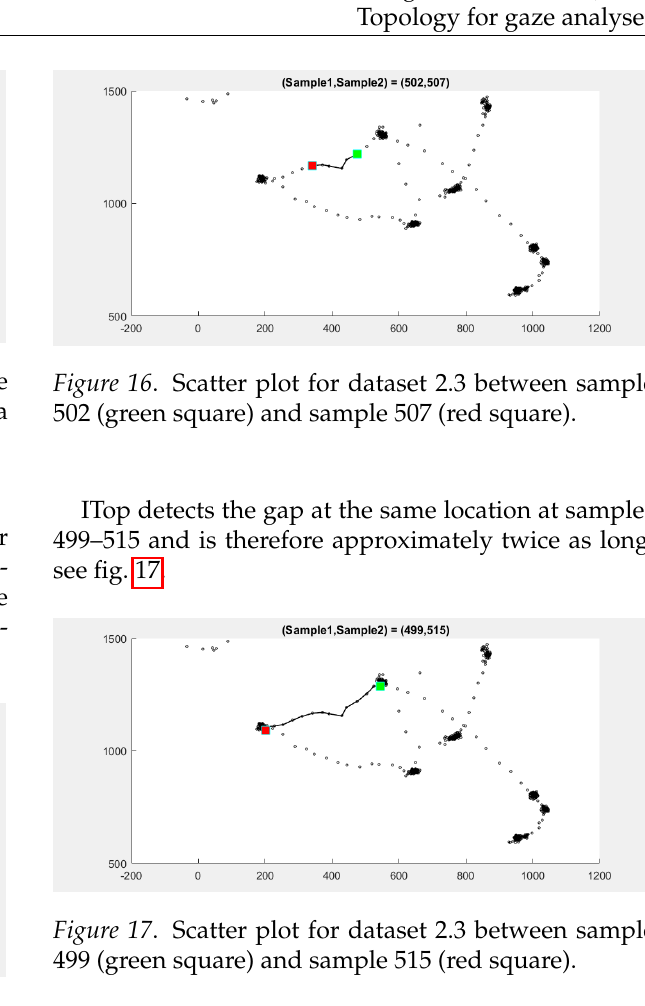
Figure 15 . Position plot for dataset 1.3 between sample 533 (green line) and sample 543 (red line) showing a small jump in the mean of the y-position after stopping. The jump occurs at the red line.